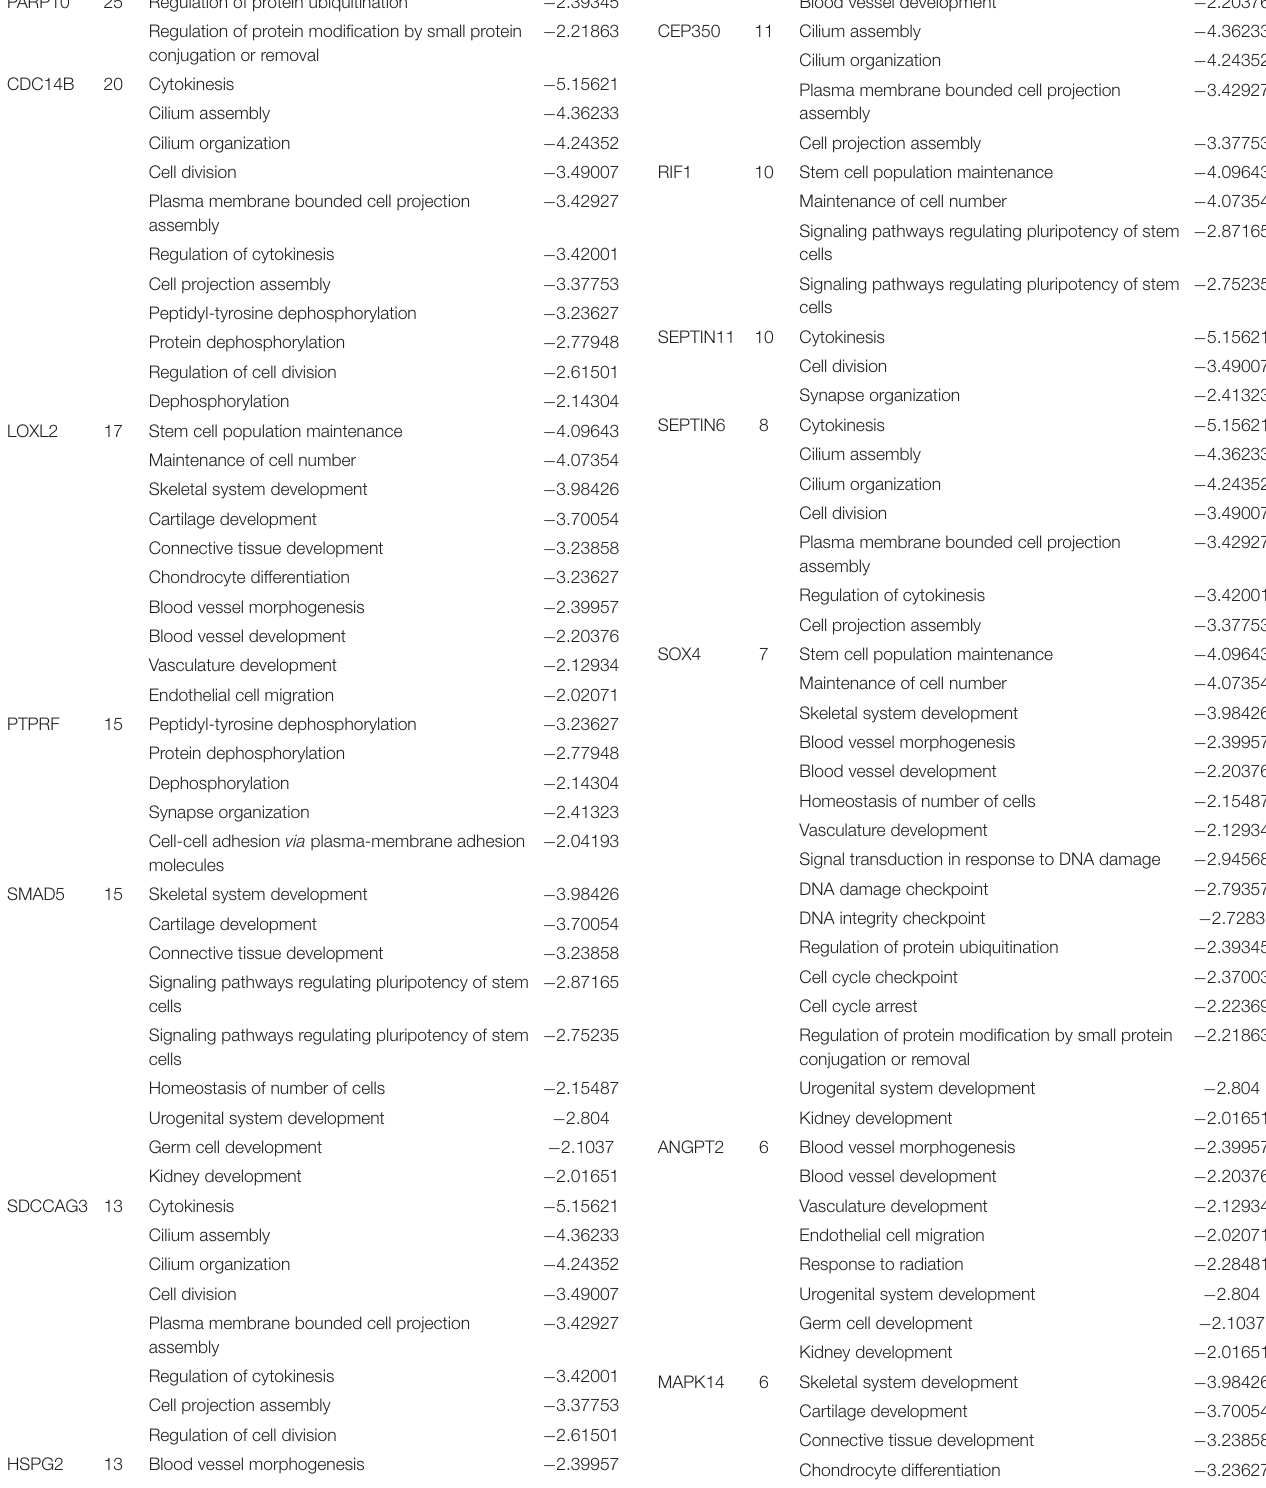
TABLE 1 | List of gene hubs based on pathway